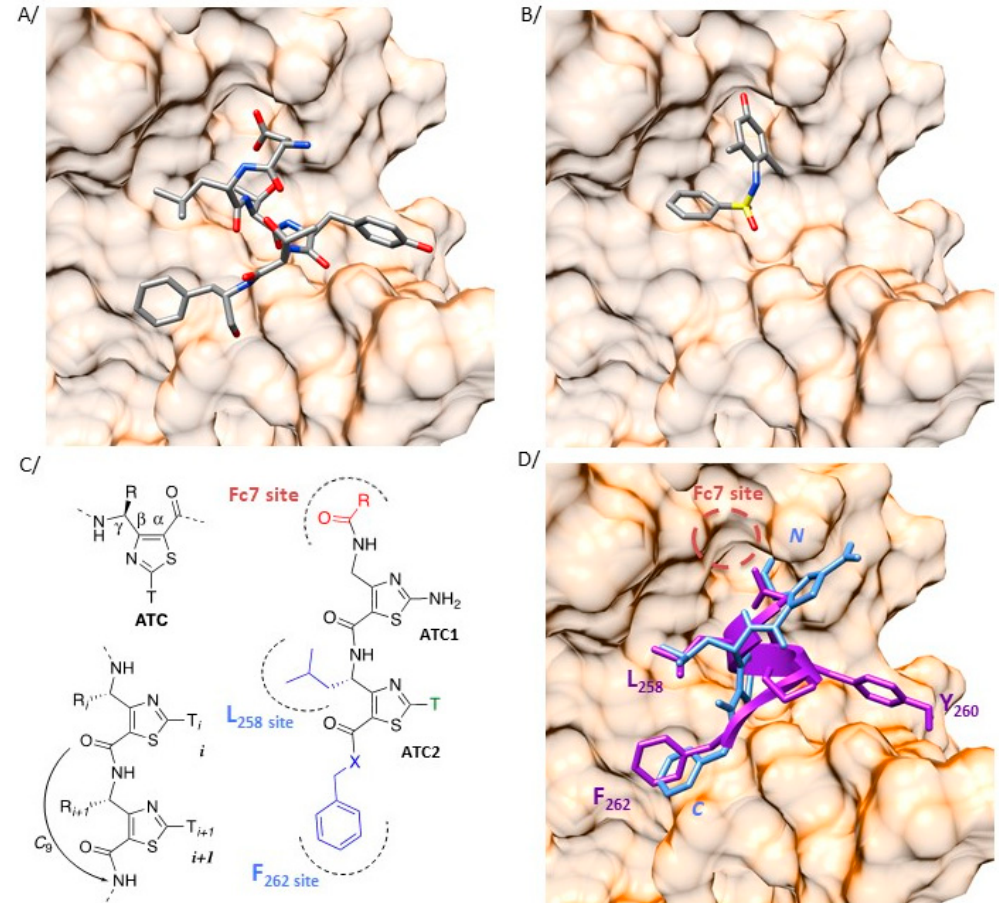
Figure 2. Heteroaromatic γ -dipeptide to mimic the auto inhibitory domain of cytohesin proteins. ( A ) Crystal structure (2R09) of the region of the guanine nucleotide exchange factor general receptor of phosphoinositides-1 (GEF GRP1) interacting with the switch I and switch II regions of Arf proteins (surface representation). The intrinsic autoinhibitory peptide of GRP1 (257-DLTYTF-262) is represented in stick (stick representation, colored by elements with carbon in grey, oxygen in red, nitrogen in blue, and sulfur in yellow). ( B ) Crystallographic pose (4JWL) of Fc7 (stick representation, colored by elements, as previously described) at the same region of the Sec7 domain of Arno (surface representation). ( C ) Nomenclature of 4-amino-(methyl)-1,3-thiazole-5-carboxylic acid (ATC) γ -amino acids and characteristic H-bonding network of the oligomers. In the designed ATC dipeptides, the substituents in blue point towards the L258 and F262 binding sites while the Fc7 binding site is targeted by the N -ter extremity (red). ( D ) The intrinsic autoinhibitory peptide of GRP1 (257-DLTYTF-262) and the γ -dipeptide based mimic are represented in purple ribbon and blue stick, respectively. The three-dimensional (3D) side chain projection around the ATC scaffold was determined from the ATC XRD structure (CSD entry AGEZAP/922304). The Fc7 binding site is indicated as a red dash circle.